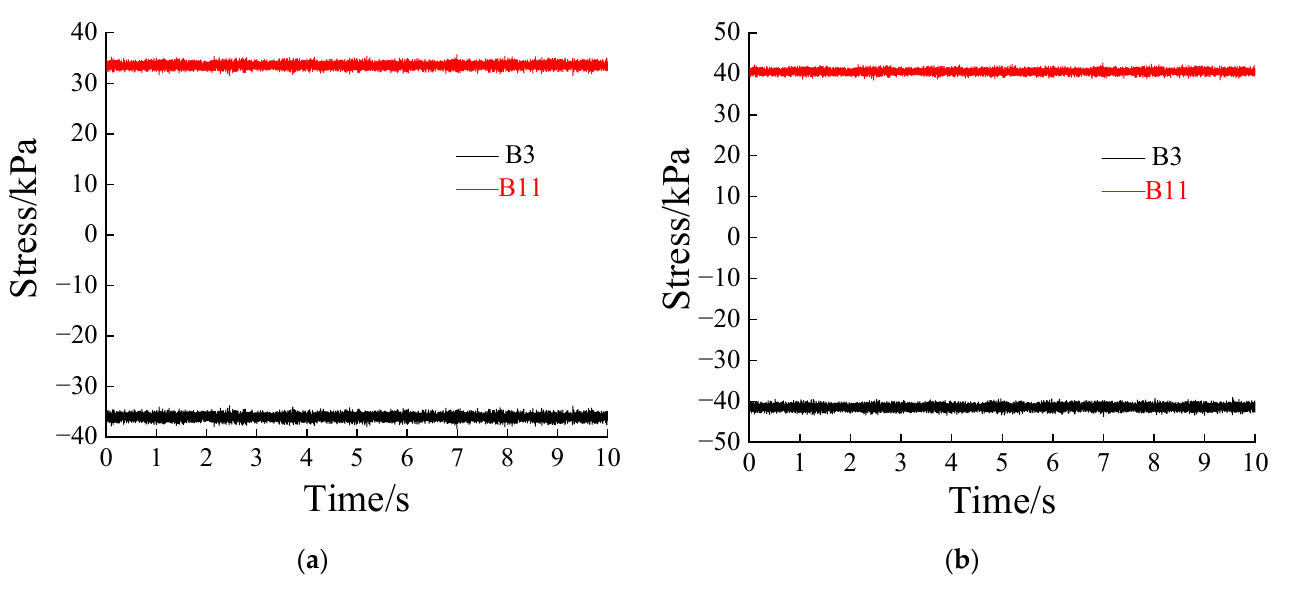
Figure 16. Stress-time curve of typical tunnel measurement points: ( a ) no base void; ( b ) with base void. Table 5 lists the statistics of the peak stress at each measuring point of the tunnel invert.